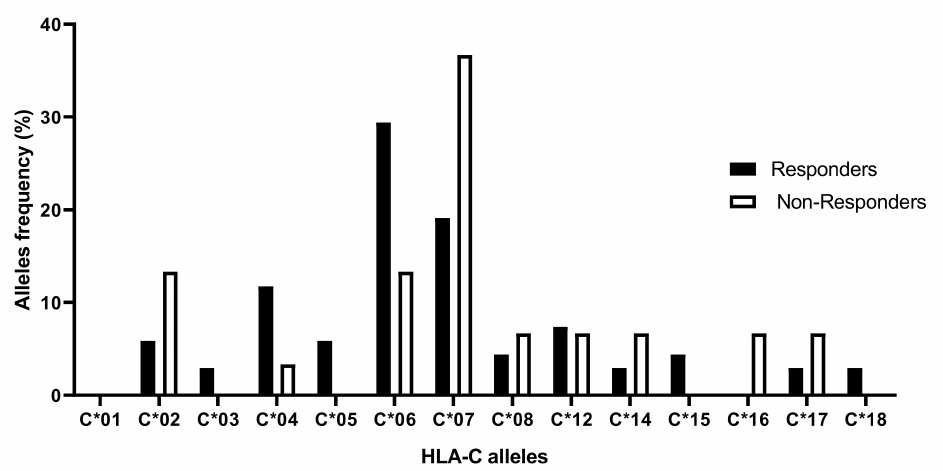
Figure 4. HLA-C allelic frequencies in responders and non-responders to